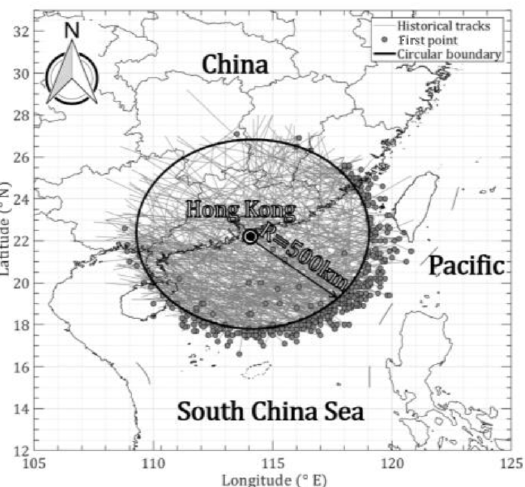
Figure 2. Track segments within a circular region centered on Hong Kong with a radius of 500km.